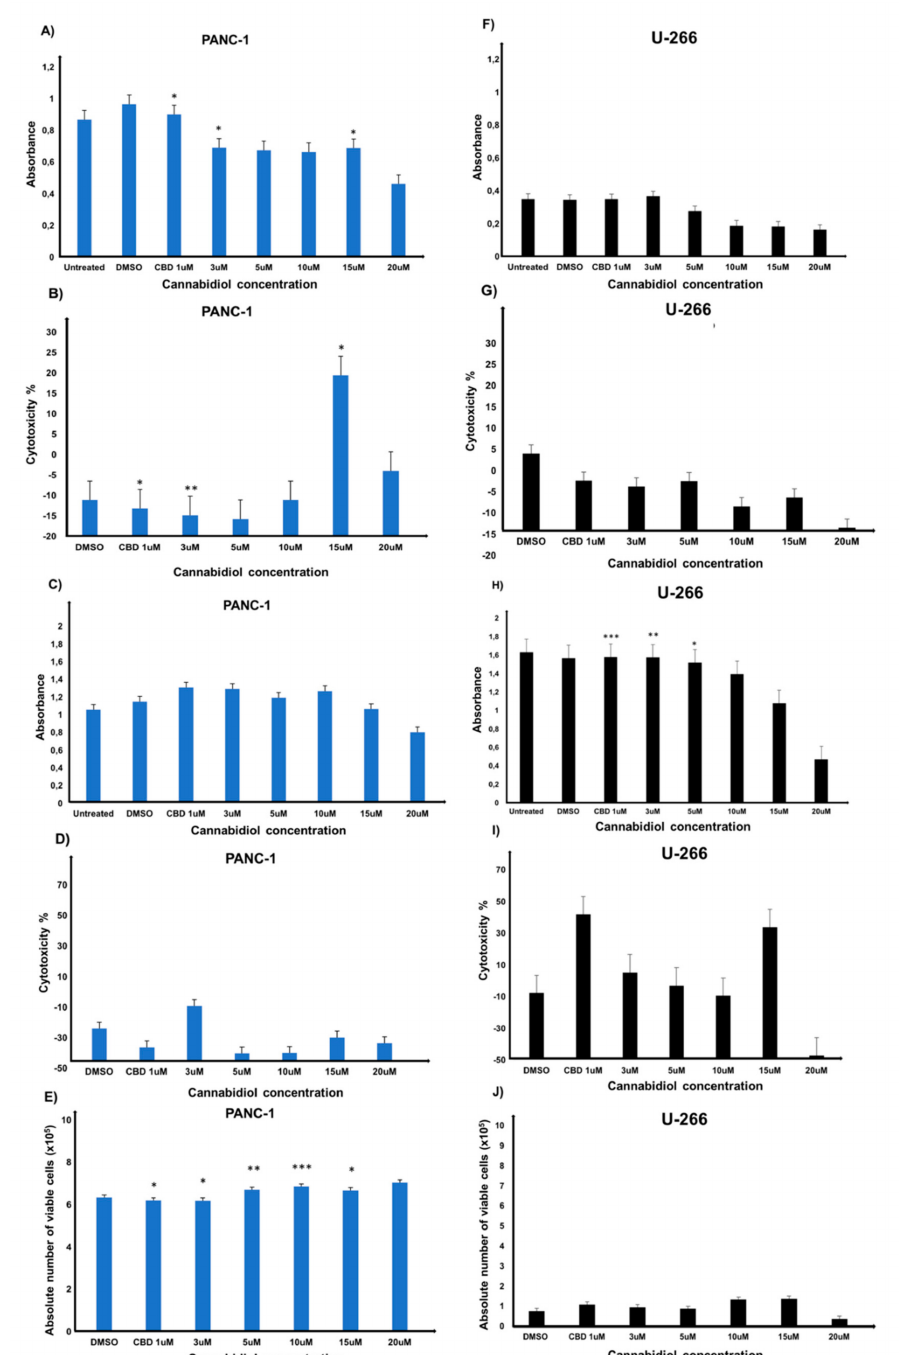
Figure 4. The cell viability in PANC–1 cells exposed to various concentrations of CBD by ( A ) CCK–8 assay and ( B ) LDH assay. The cell viability of the co–cultured CIKs and PANC–1 cells at E:T ratio of 10:1 by ( C ) CCK–8 assay and ( D ) LDH assay. ( E ) The absolute number of viable PANC–1 cells for each sample condition with cocultured CIKs and PANC–1 cells at an E:T ratio of 10:1. The cell viability in U–266 cells exposed to various concentrations of CBD by ( F ) CCK–8 assay and ( G ) LDH assay. The cell viability of the co–cultured CIKs and U–266 cells at E:T ratio of 10:1 by ( H ) CCK–8 assay and ( I ) LDH assay. ( J ) The absolute number of viable U–266 cells for each sample condition with cocultured CIKs and PANC–1 cells at an E:T ratio of 10:1 (* p < 0.05, ** p < 0.01, *** p <